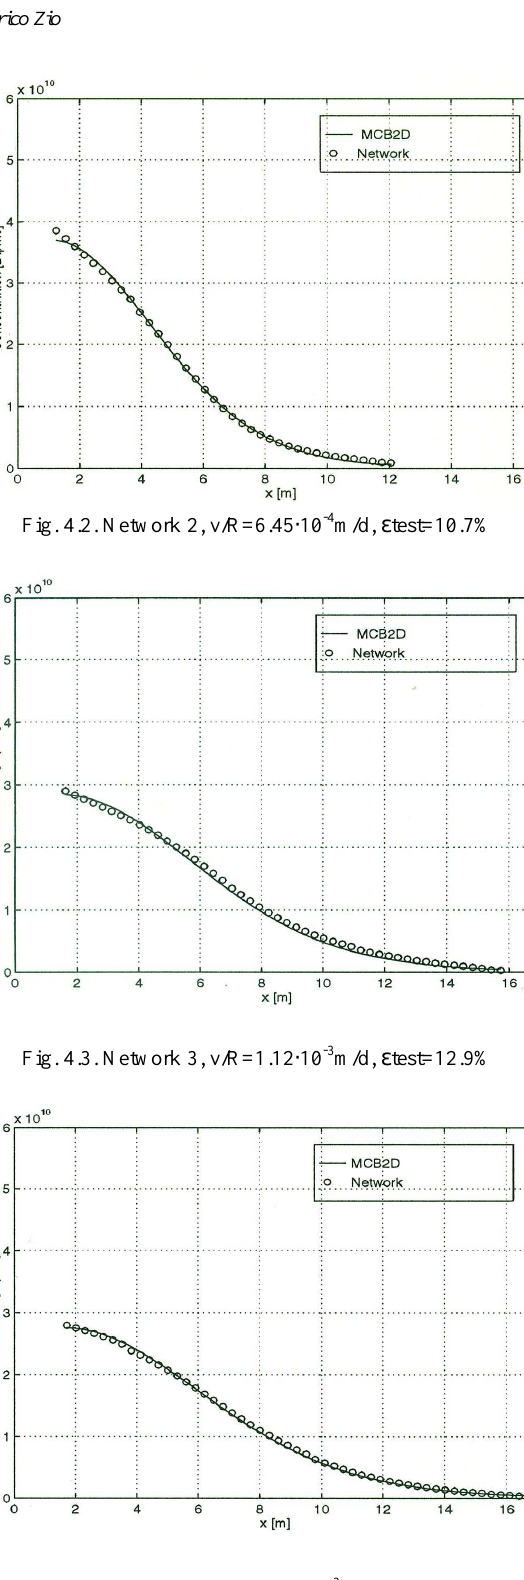
Fig. 4.4. Network 4, v/R=2.58 (cid:215) 10 -3 m/d, e test=5.0%